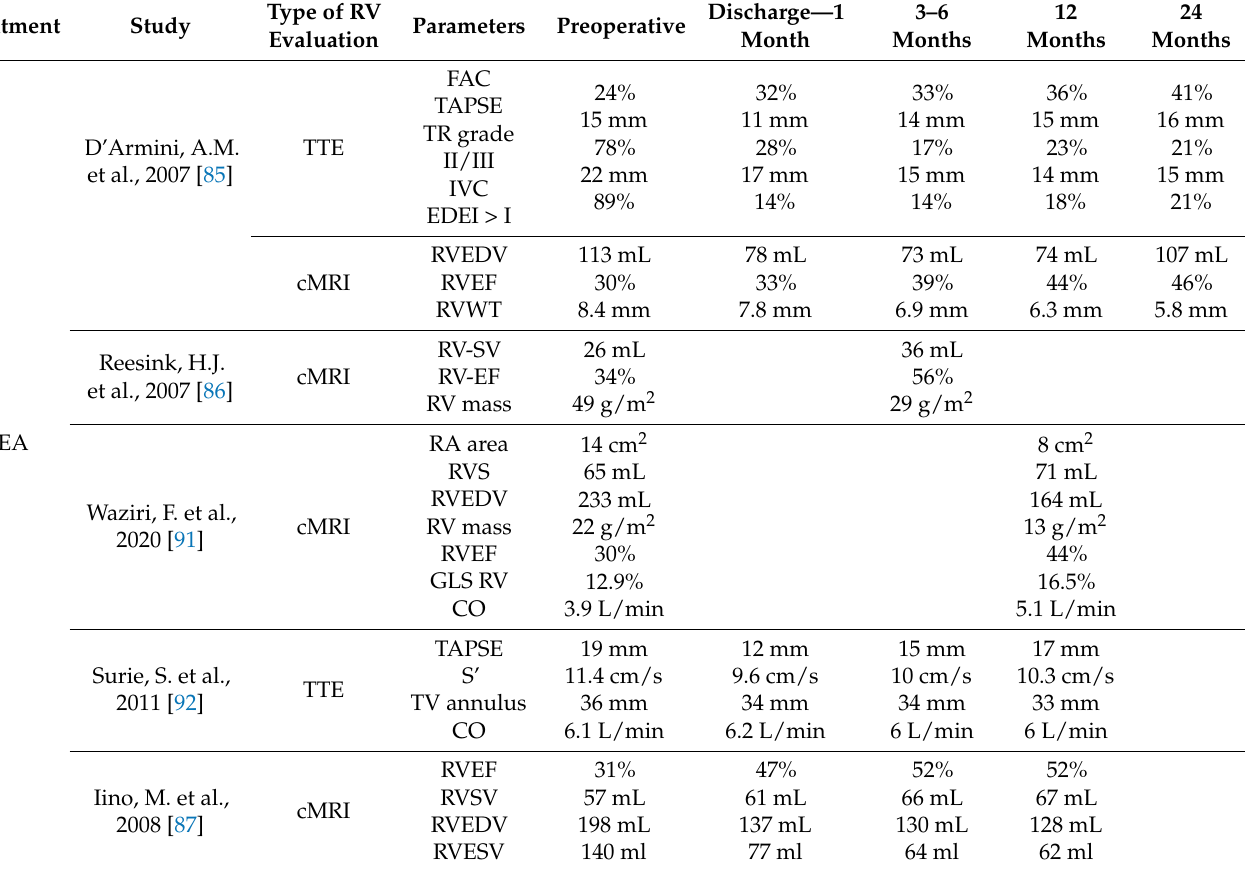
Table 1. Evolution of right ventricular (RV) function after pulmonary endarterectomy (PEA), balloon pulmonary angioplasty (BPA), and riogicuat. cMRI = cardiac magnetic resonance imag- ing; CO = cardiac output; EDEI = end-diastolic eccentricity index; IVC = inferior vena cava; GLS = global longitudinal strain; RA = right atrium; RVEDAI = right ventricular end-diastolic area index; RVEDV = right ventricular end-diastolic volume; RVSV = right ventricular stroke volume; RVWT = right ventricular wall thickness; TTE = transthoracic